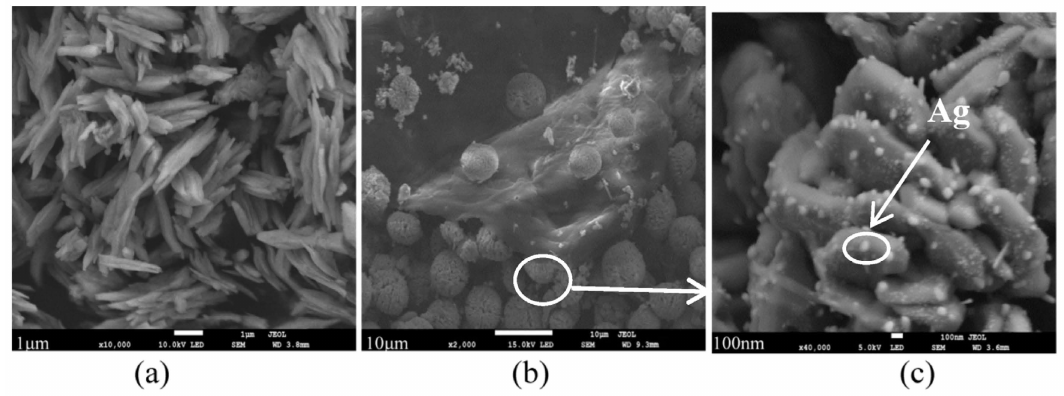
Figure 2. SEM images of: ( a ) pure BiVO 4 ; ( b ) AgGB-0.5; and ( c ) AgGB-0.5 at higher